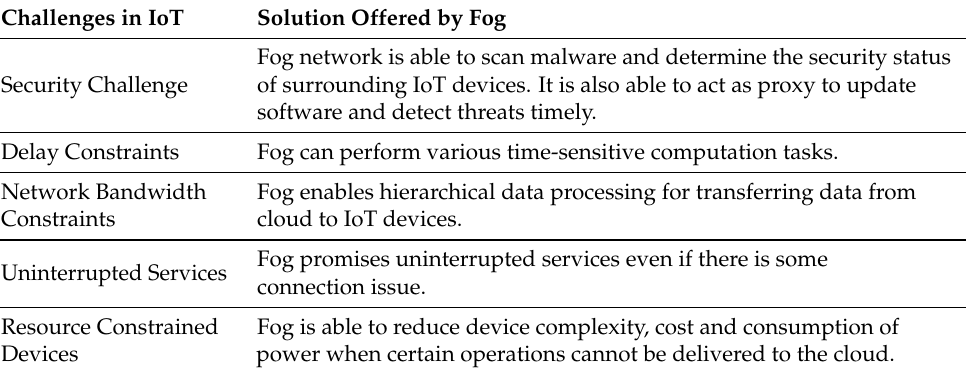
Table 6. Summary of IoT challenges and fog